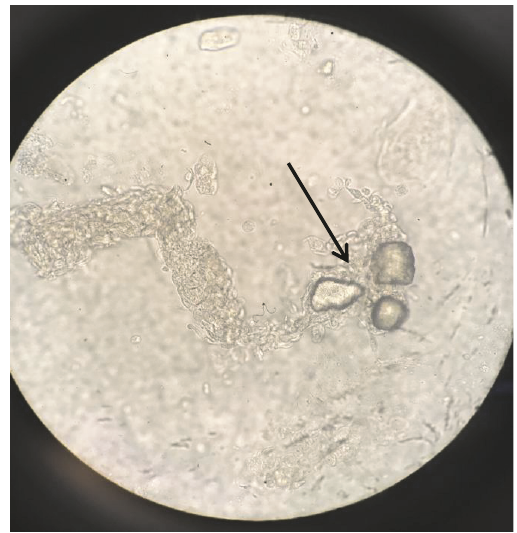
Figure 3: Diamond shaped uric acid crystals embedded in granular cast under high power